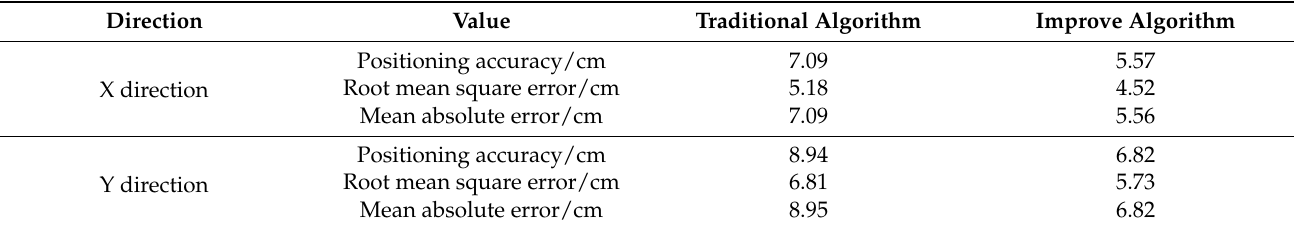
Table 2. Static positioning test results.